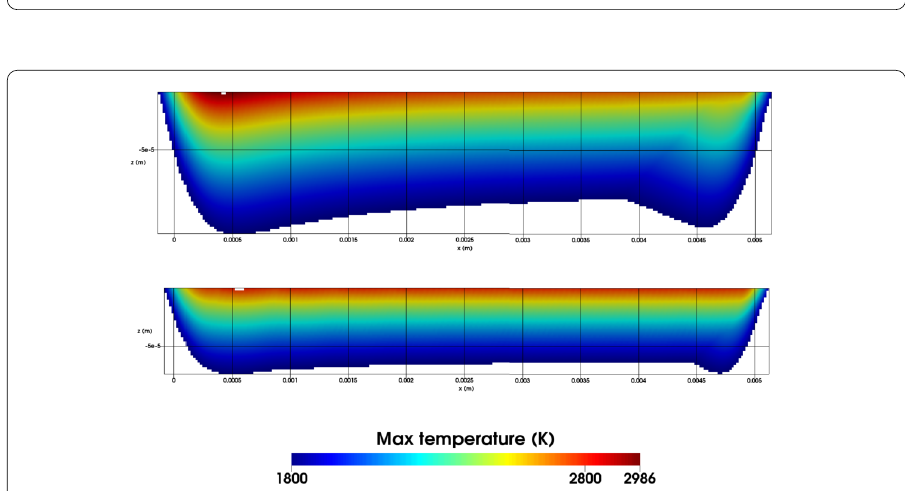
Figure 10 Beam path in Example 2 for melting the first quadrant of an annulus with r i = 1 mm and outer radius r o = 5 mm. The entire beam path consists of 19 lines of length 4 mm. Each line is divided into 8 segments of equal length 0.5 mm. Only the blue part, C s , of the entire beam path is considered during optimization and the results from this optimization is then extended to the entire beam path. The path consists of 40 segments that are separated by the small ticks. The thin gray lines indicate the secondary path C wd